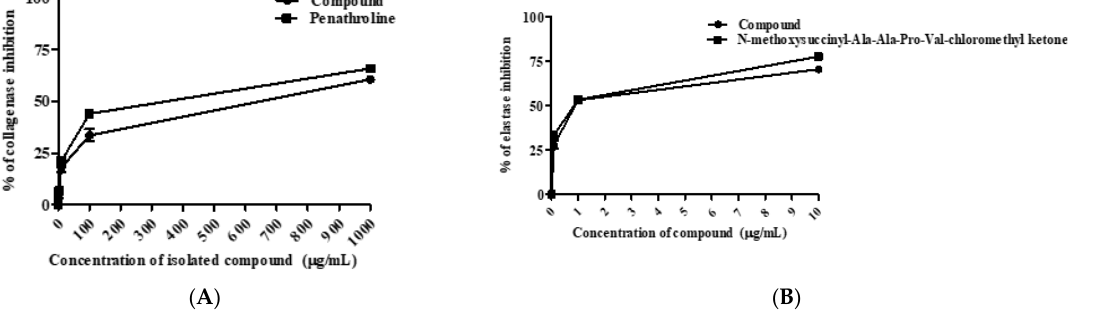
Figure 3. Collagenase ( A ) and elastase ( B ) inhibitory activities of isolated compound. All determi- nations were carried out in triplicate and the values are expressed as the mean ± SD.